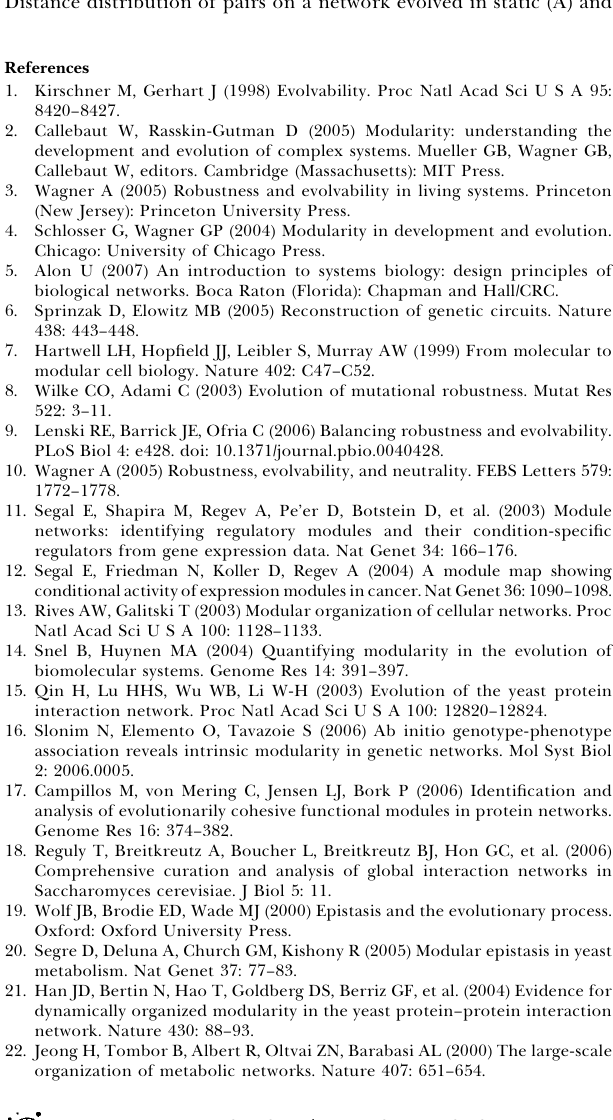
quasi-static (B) environment. Red, synthetic lethal pairs; green, knockdown suppressor pairs; black, random pairs. Found at doi:10.1371/journal.pcbi.0040023.sg007 (409 KB PDF). Figure S8. Fraction of Genes Producing Precursors Fraction of genes involved in the production of one of the 53 precursor molecules for the network evolved in a dynamic environ- ment (red) versus a static environment (green line). Found at doi:10.1371/journal.pcbi.0040023.sg008 (409 KB PDF). Table S1. Organization of a 72 bp Gene Found at doi:10.1371/journal.pcbi.0040023.st001 (409 KB